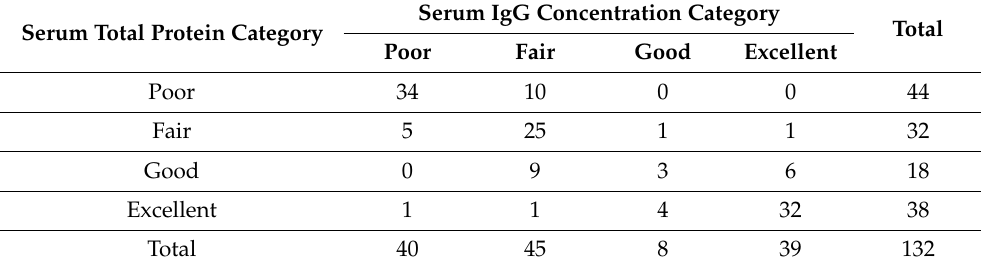
Table 3. Comparison of 132 randomly selected samples tested for both serum total protein concentra- tion and serum IgG concentration.